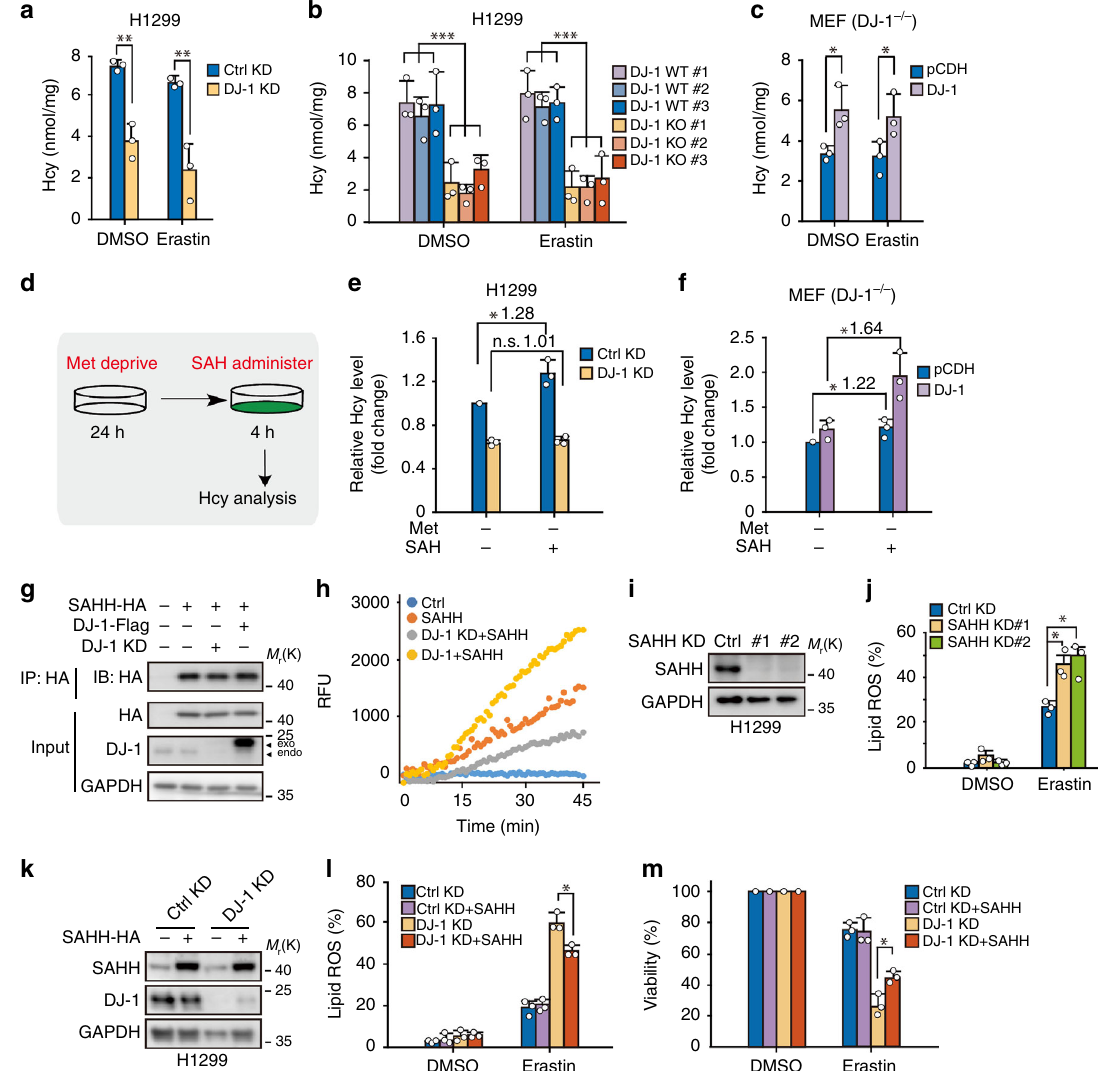
Fig. 5 DJ-1 depletion disrupts the generation of Hcy from SAH via impairing intracellular SAHH activity. a – c ELISA assays for the levels of endocellular Hcy. Indicated DJ-1 KD H1299 cells a and DJ-1 KO H1299 cells b were treated with erastin (2 μ M) for 12 h, and the Hcy levels were assayed. Indicated MEFs c were treated with erastin (400 nM) for 12 h, and the Hcy levels were assayed. d – f Indicated cells were deprived from Met for 24 h, followed by adding the extra SAH to the cells for 4 h, and Hcy levels we detected by ELISA. d The schematic representation of experiment design. The relative Hcy levels in indicated H1299 cells e and MEFs f are shown. g , h DJ-1 increased the enzymatic activity of SAHH. g Indicated HEK293T cells with either DJ-1 overexpression or KD (#1 sequence of DJ-1 KD was used here) were further transfected with SAHH-HA plasmids. Cell lysates were immunoprecipitated with anti-HA antibody, followed by immunoblotting with anti-HA antibody. Independent experiments are repeated three times and representative data are shown. h The activity of ectopic SAHH from cells by immunoprecipitation was assayed as mentioned in Methods section. Independent experiments were repeated three times and representative data are shown. i Western blot analysis of SAHH expression in H1299 cells with SAHH KD. Independent experiments are repeated three times and representative data are shown. j Indicated SAHH KD H1299 cells were treated with erastin (2 μ M) for 12 h, and lipid ROS production was assayed by fl ow cytometry using C11-BODIPY. k Western blot analysis of DJ-1 and SAHH expression in indicated H1299 cells (#1 sequence of DJ-1 KD was used here). Independent experiments are repeated three times and representative data are shown. l Indicated DJ-1 KD (#1 sequence) and SAHH overexpression H1299 cells were treated with erastin (2 μ M) for 12 h, and lipid ROS production was assayed. m Cell viability was assayed in indicated cells treated with 2 μ M erastin for 36 h. Data shown represent mean ± SD from three independent experiments. Comparisons were made using the two-tailed, unpaired Student ’ s t -test; * p < 0.05, ** p < 0.01, *** p < 0.001; n.s., no statistic